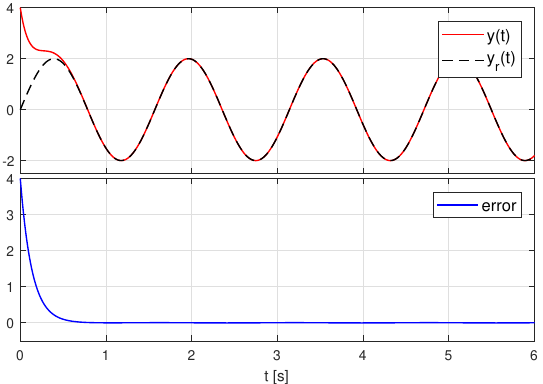
Figure 1. Performance of the regulator for λ = 2.5 with Γ 1 = 1.8424, Γ 2 = 1, Γ 3 = − 0.5, and Γ 4 = 0.